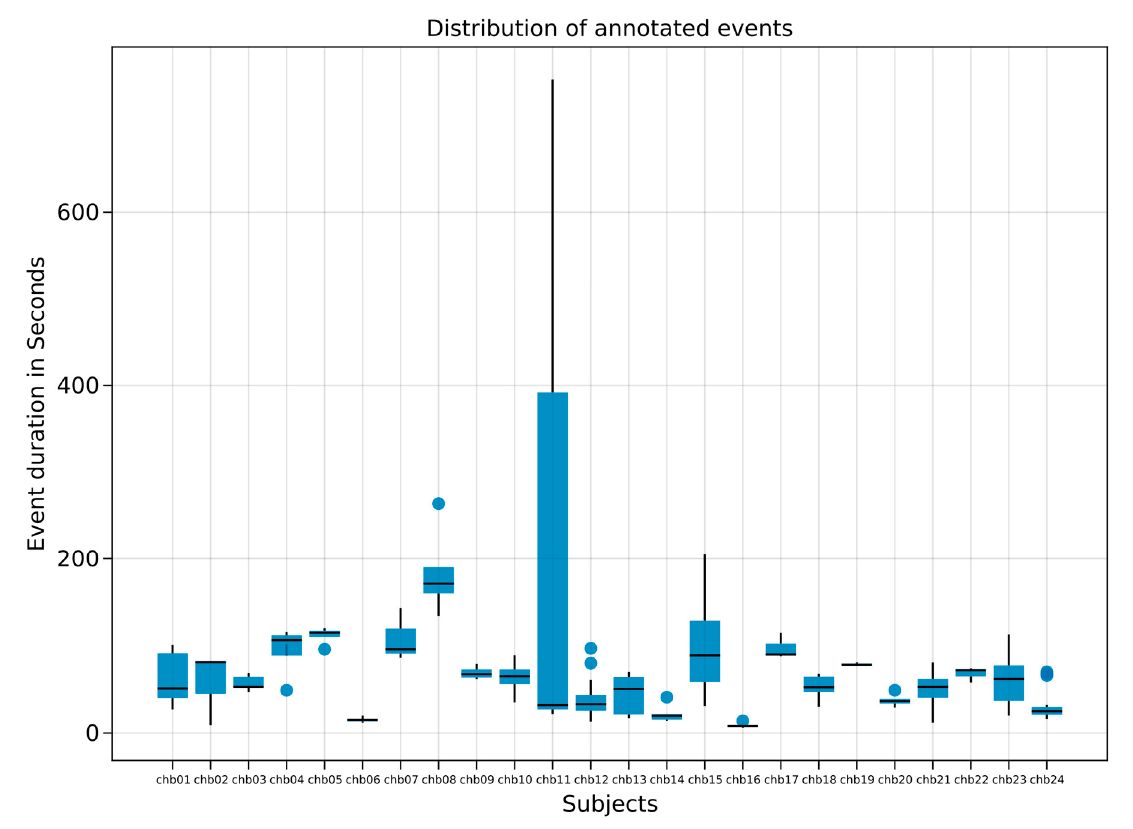
Figure 2. Boxplot of duration of annotated seizures per subject. Y axis indicates duration measured in seconds. X axis illustrates subject.